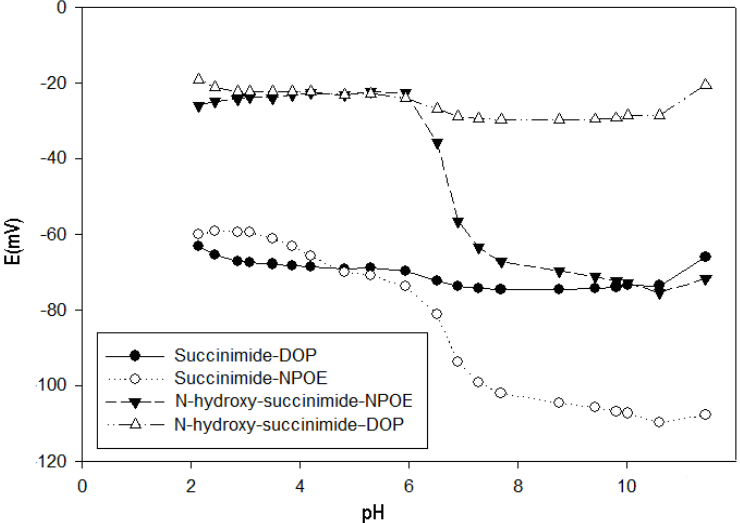
Figure 2. Effect of the pH on the response of the electrodes at 1 × 10 − 3 M Cu(II)